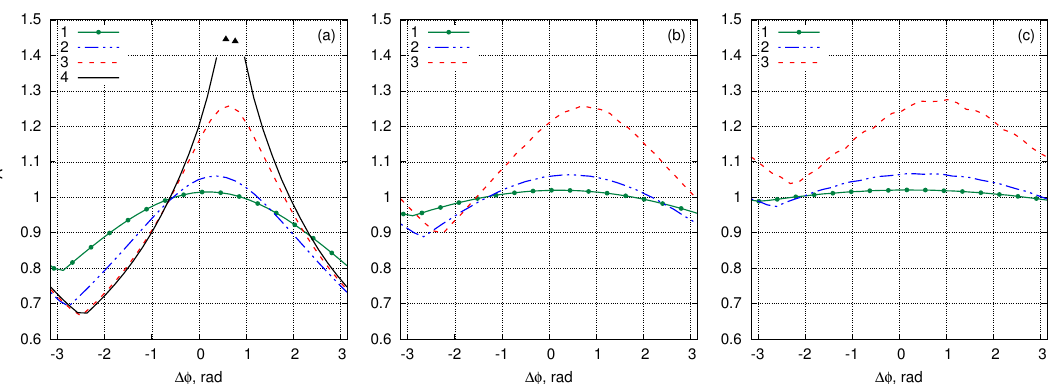
Figure 5. The maximum amplification A of the wave field amplitude of colliding breathers depending on the relative phase ∆ φ for the all four numerical experiments performed in this work. The green solid curves 1 with dots corresponds to experiment 1 , the blue dash-dotted curves 2 with dots— experiment 2 , the red dashed curves 3 with dots— experiment 3 , the black solid curve 4— experiment 4 . The black triangles mark the wave breaking. Panels ( a – c ) correspond to the three different values of the relative velocities of the breathers in ascending order. The values of all parameters are listed in the Table 1. For experiment 3 with ∆ V = 8% the maximum value of amplitude amplification A ( ∆ φ )